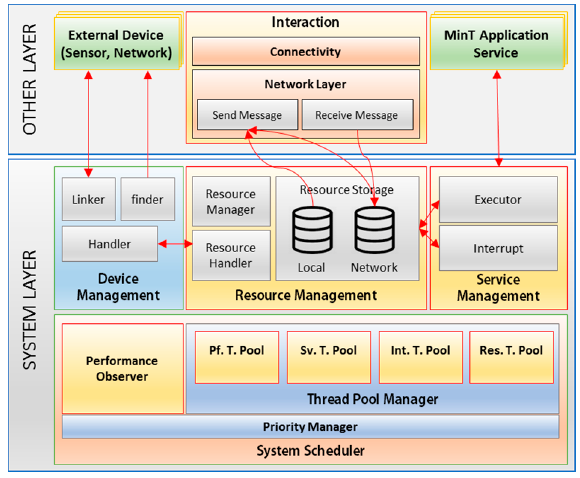
Figure 8. System layer structure.